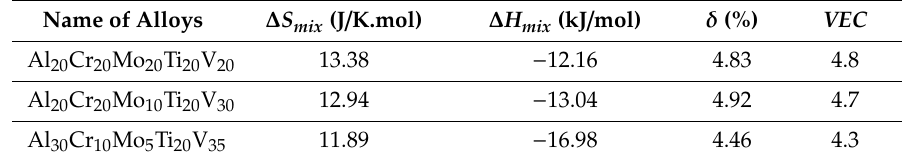
Table 1. Calculated values of entropy of mixing ( ∆ S mix ) , mixing enthalpy ( ∆ H mix ), valence electron concentration ( VEC) , and atomic size di ff erences ( δ ) of the refractory high-entropy alloys (RHEAs). Name of Alloys ∆ S mix (J /